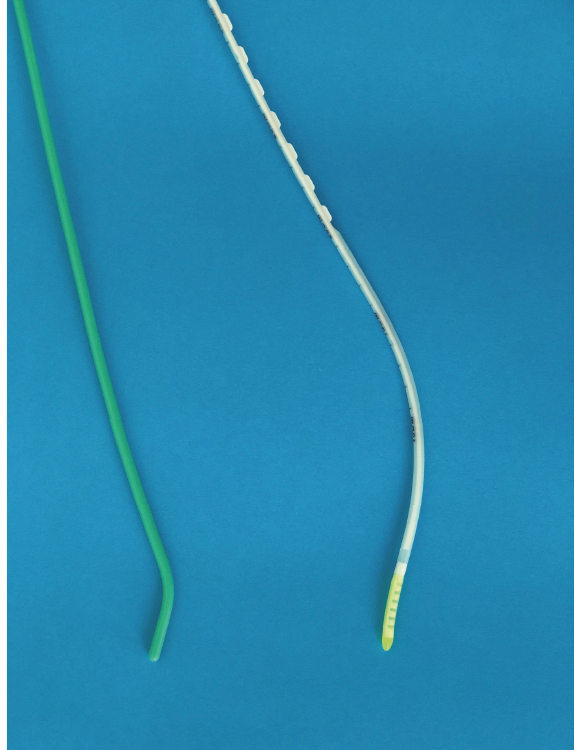
Figure 1: (a) Standard bougie stylet; (b) the new flexible tip bougie